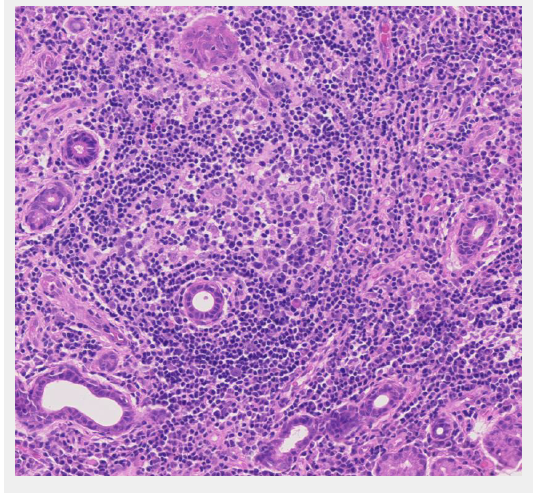
Germinal centre-like structure in a primary Sjögren’s syndrome salivary